Question: What type of chart is this?
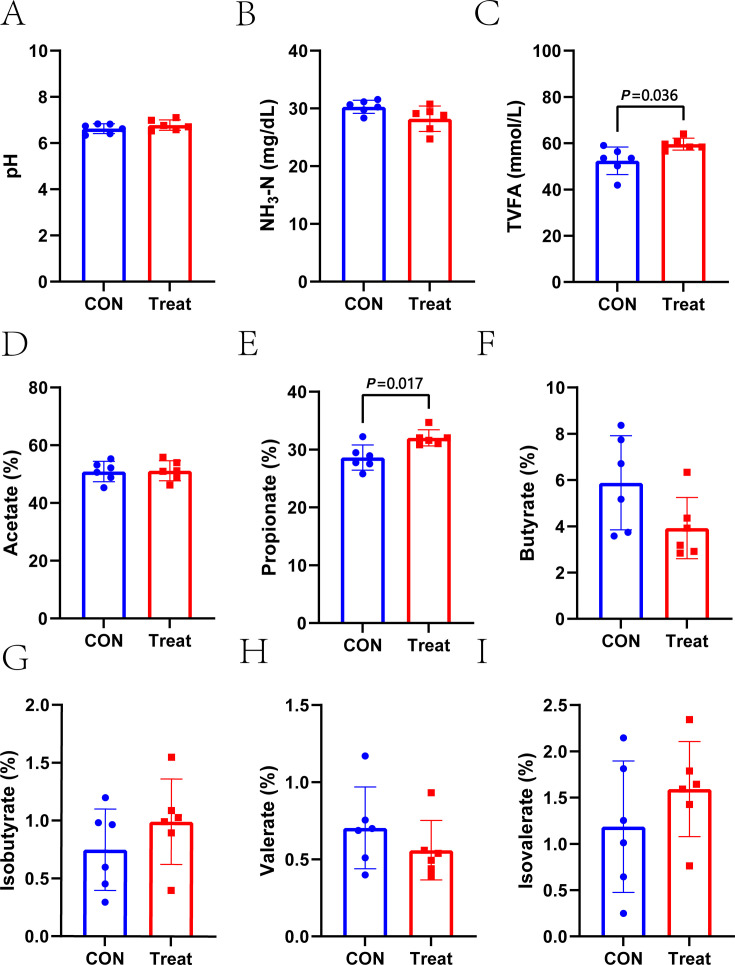
Answer: bar